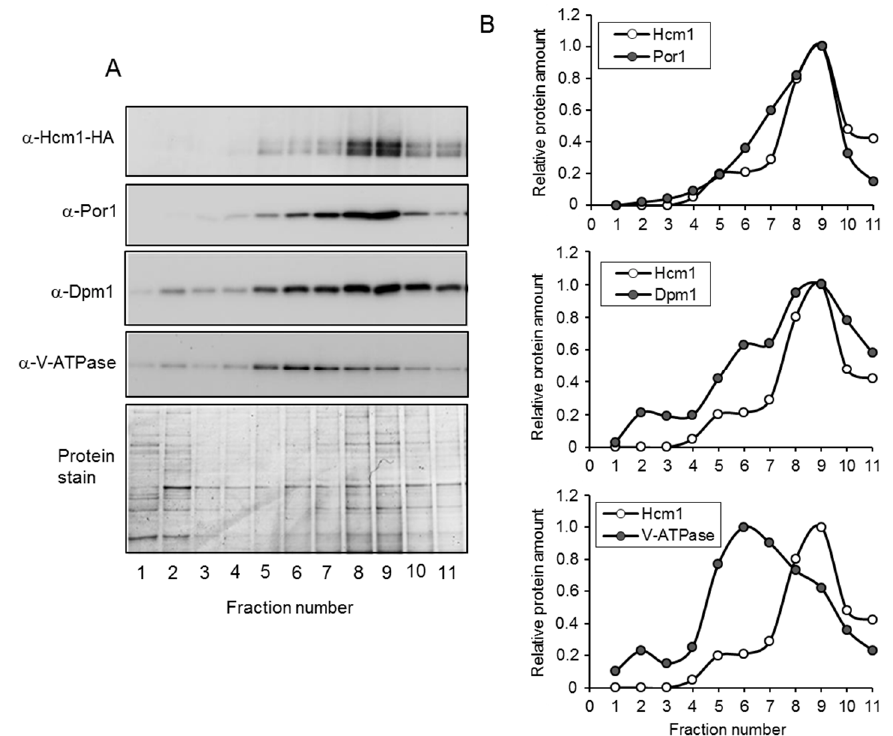
Figure 3. Fraction analysis of the sucrose gradient centrifugation used in mitochondrial purification. ( A ) Mitochondrial-enriched fractions from tetHCM1-HA cells were separated by four-phase sucrose gradient centrifugation. The distribution of Hcm1 was analyzed in each fraction by Western blot with anti-HA. Western blot anti-porin (mitochondria), anti-V-ATPase (vacuole), and anti-Dpm1 (ER) were used as markers of these organelles. Fractions 1 to 11 represent the top and the bottom of the sucrose density gradient, respectively. Protein stain with Brilliant Coomassie Blue is shown as a loading control. ( B ) Bands corresponding to Hcm1, porin, V-TPase, and Dpm1 in A were quantified. In each image, the fraction with the highest value was normalized to 1.